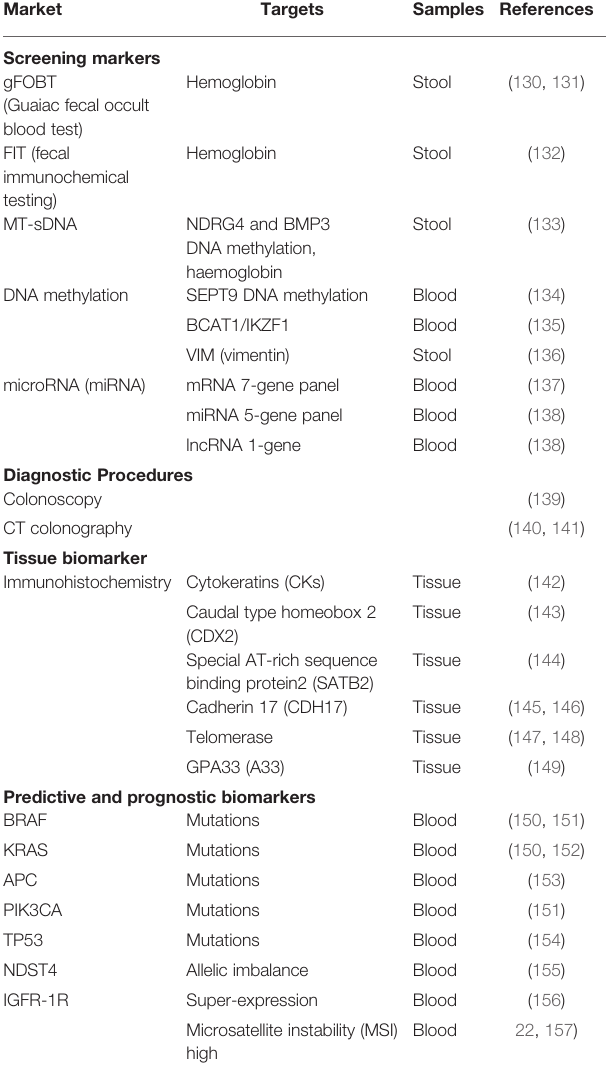
TABLE 2 | Biochemical markers used for colorectal cancer screening, diagnosis, and assessment of treatment ef fi